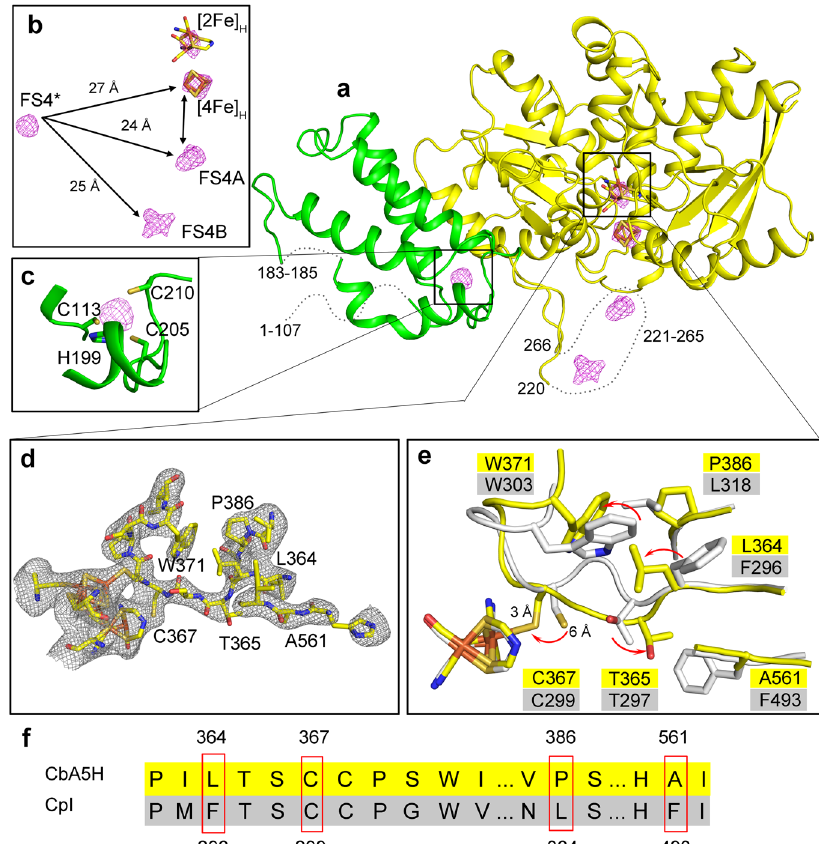
Fig. 2 X-ray structure of CbA5H WT crystallized under aerobic conditions (CbA5H air ). a Cartoon structure of CbA5H air (PDB ID: 6TTL, chain A; see Supplementary Figure 2 for the homodimer). H- and F-domain are colored in yellow, the N-terminal SLBB domain (soluble ligand binding β -grasp) 51 is presented in green. b Anomalous electron density map, depicting the positions and distances between iron-sulfur clusters, including the H-cluster (stick model), the two F-clusters (FS4A and FS4B) and the additional N-terminal cluster within the SLBB domain (FS4*) located more than 20 Å away from any other cluster. c Potential cluster coordination site within the SLBB domain, consisting of 3 cysteine and one histidine ligand. d , e CbA5H air exhibits a characteristic structural displacement of the peptide loop containing C367 (TSC-loop) nearby the [2Fe] H -cluster. d The omit map ( Fo-Fc ) was contoured at 2 σ (see Supplementary Fig. 17 for a more detailed structural comparison between the loop regions of CpI and CbA5H air ). e Structural alignment, depicting conformational differences between CbA5H air (yellow) and CpI (white). Panels d and e focus on the [2Fe] H -cluster and side chains of amino acids which in fl uence anaerobic inactivation, O 2 -resistance, and H inact formation. f Selected parts of an amino acid sequence alignment of CbA5H WT and CpI, including the polypeptide positions that in fl uence TSC-loop recon fi guration and H inact state formation in CbA5H WT